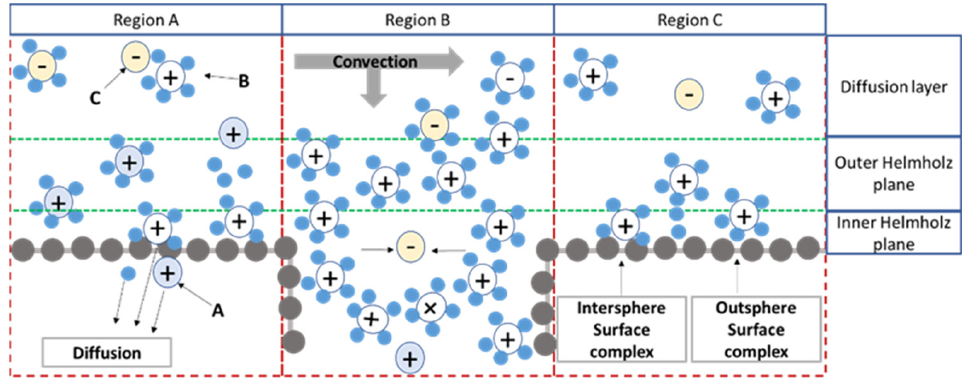
Figure 5. The mechanism of transportation through the adsorptive membranes. Reproduction from [75].